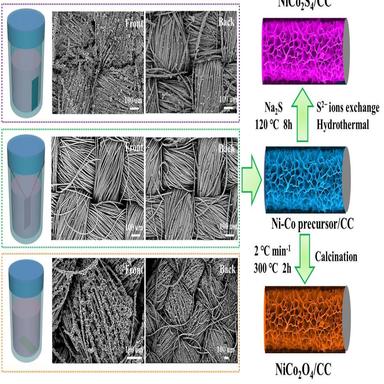
The comparison of Ni-Co precursors grown on two sides of carbon cloth by different hydrothermal methods (attachment, hanging and tiling), and schematic illustration for the formation processes of honeycomb-like NiCo2O4 and NiCo2S4 on the carbon cloth.